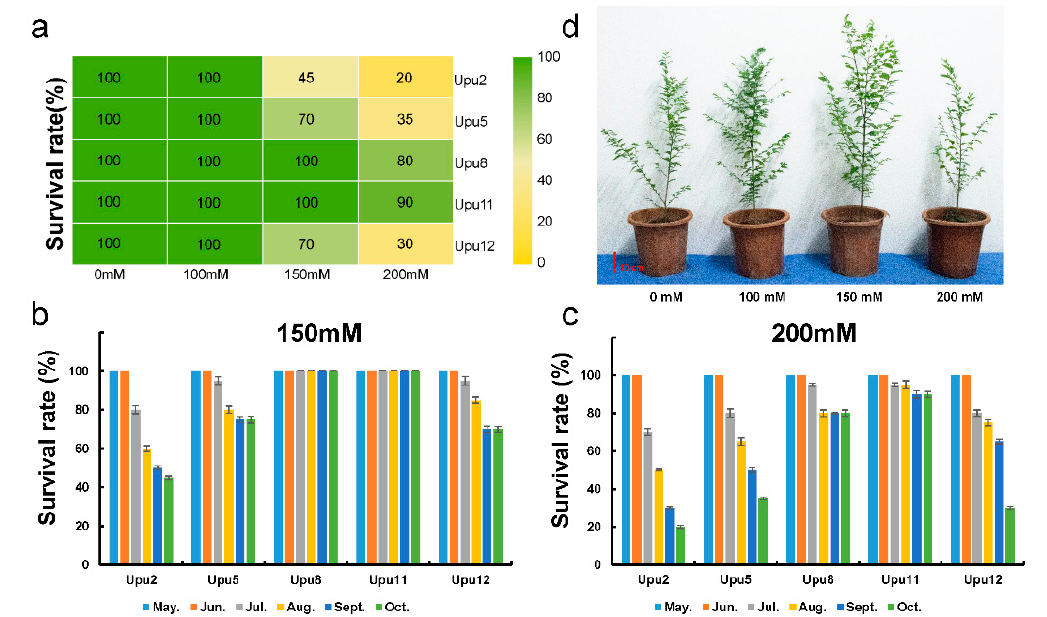
Figure 1. Survival rates of U. pumila under salt stress treatment. ( a ) Survival rates of five U. pumila cultivars under different concentrations of NaCl in October; ( b , c ) survival rates of five cultivars under 150 mM and 200 mM NaCl treatments. ( d ) Phenotypes of Upu11 under NaCl treatments in July. Scale bar 10 cm; data are presented as means ± SD ( n = 3 [3 groups × 10 plants per cultivar]).